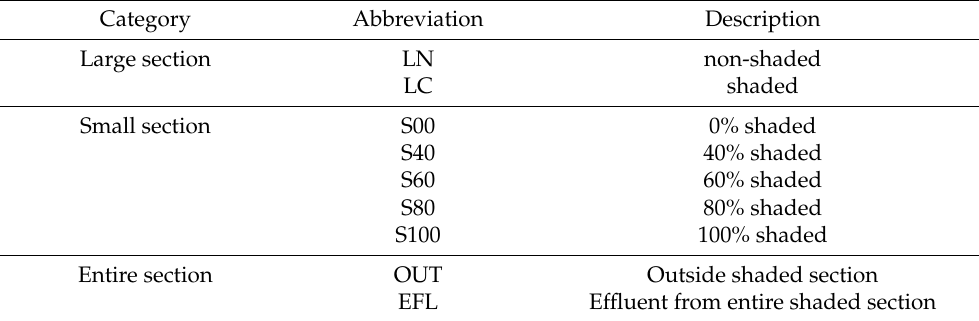
Table 1. Shading conditions.